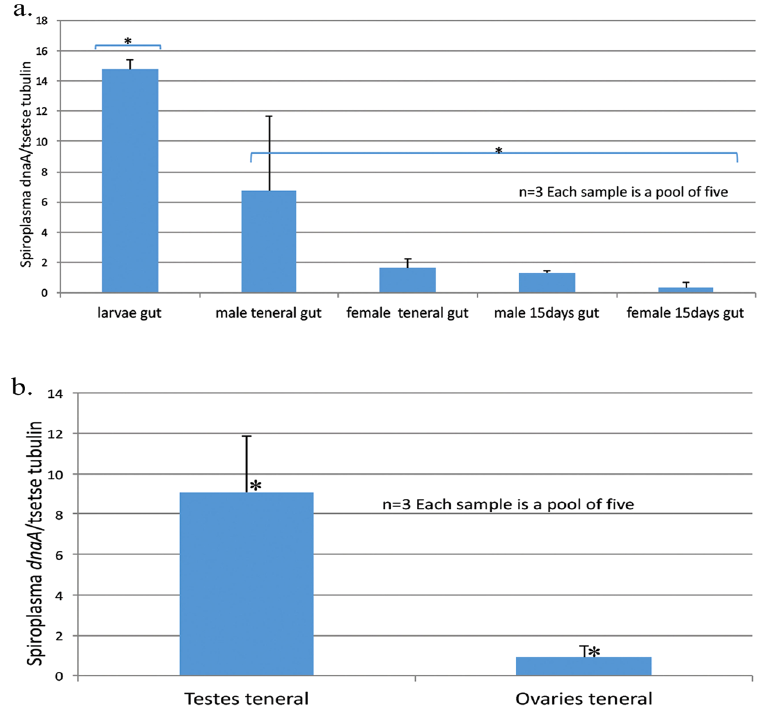
Figure 5. Quantification of Spiroplasma titre in terms of the symbiont dnaA gene copies normalized by the tsetse β -tubulin gene. ( a ) Gff gut from larvae, male and female teneral and 15-day old tsetse flies (n = 3, each sample is a po ο l of five) p < 0.005, ( b ) gonads from male and female teneral tsetse flies (n = 3, each sample is a po ο l of five), p < 0.05 (Anova test was performed; statistical significant differences are indicated with an asterisk *